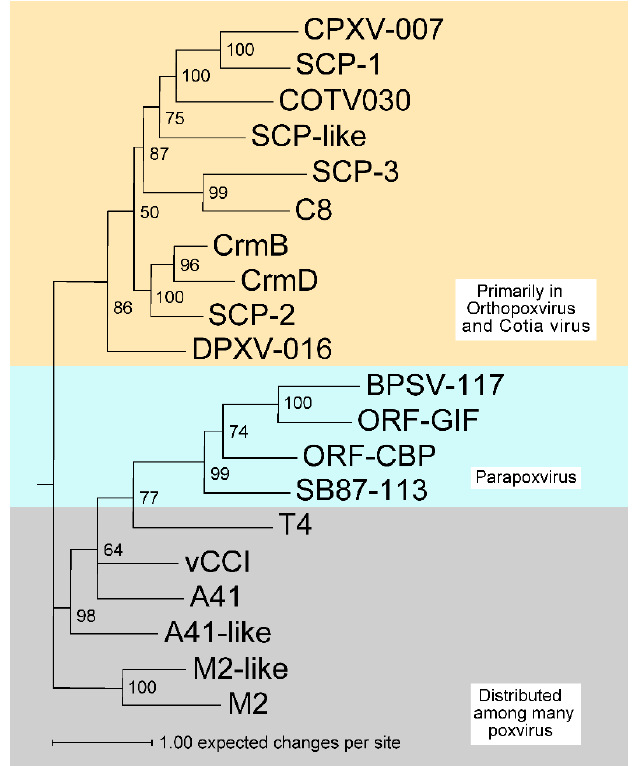
Figure 7. Dendrogram of PIE domain sequences showing relatedness among representative members of the PIE domain families. The tree is midpoint rooted for purposes of illustration. Values in percent at internal nodes indicate posterior probabilities calculated for the Bayesian inference of phylogeny from the alignment in Figure 6 using MrBayes v3.2.0 [81]. The scale bar relates branch lengths to the number of expected substitutions per site. The family names are shown at the terminal nodes.